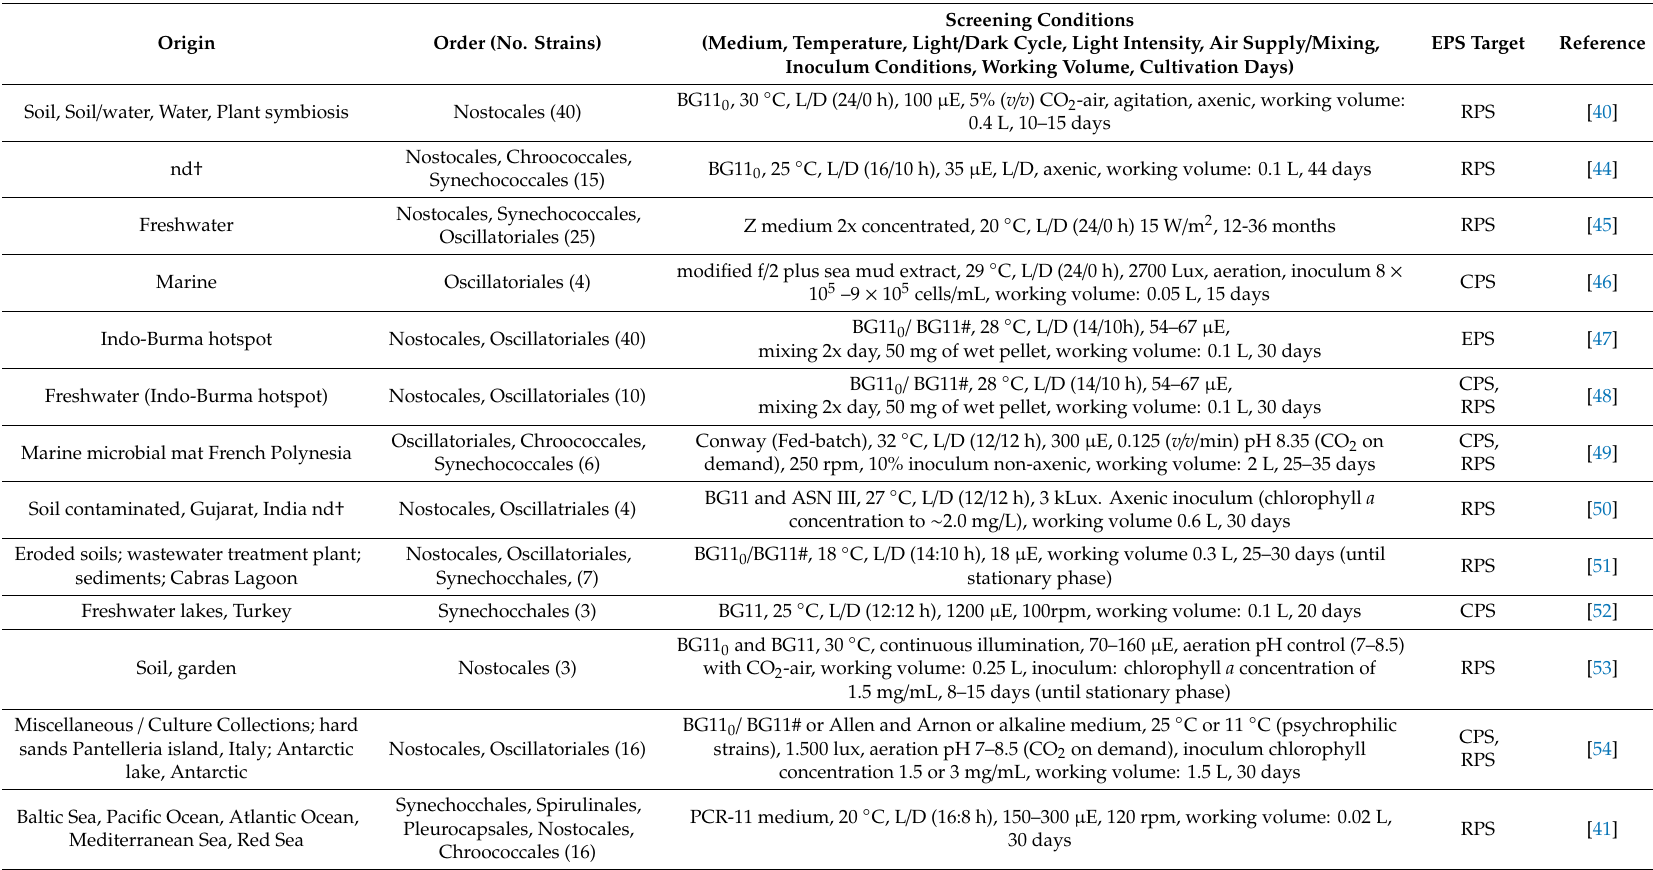
Table 2. Compilation of screening conditions applied to Cyano-EPS based on their origin and